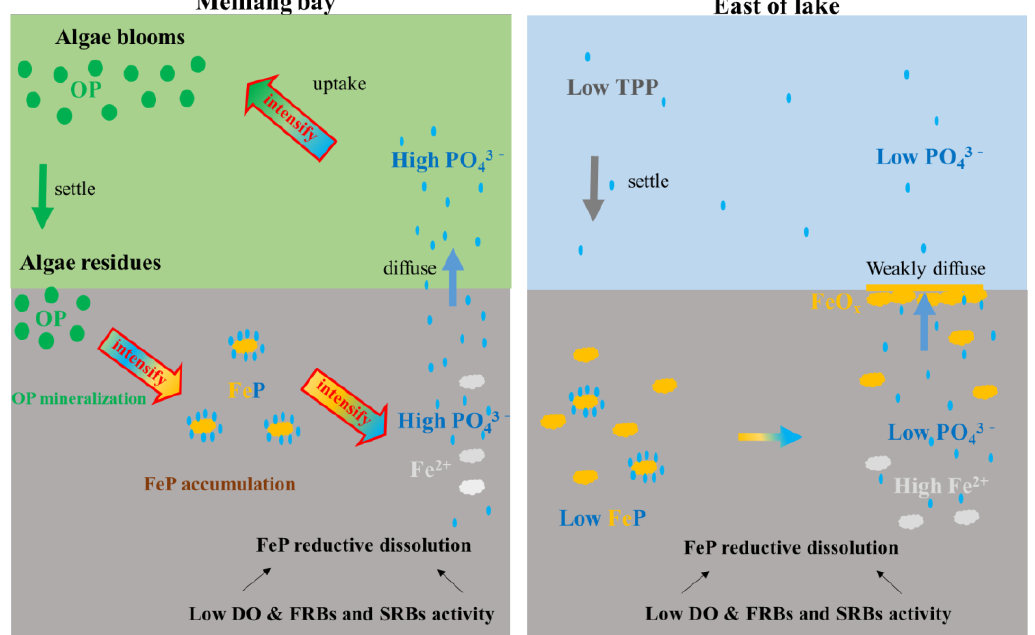
Figure 8. The P cycle patterns in Meiliang Bay and the east of the lake.